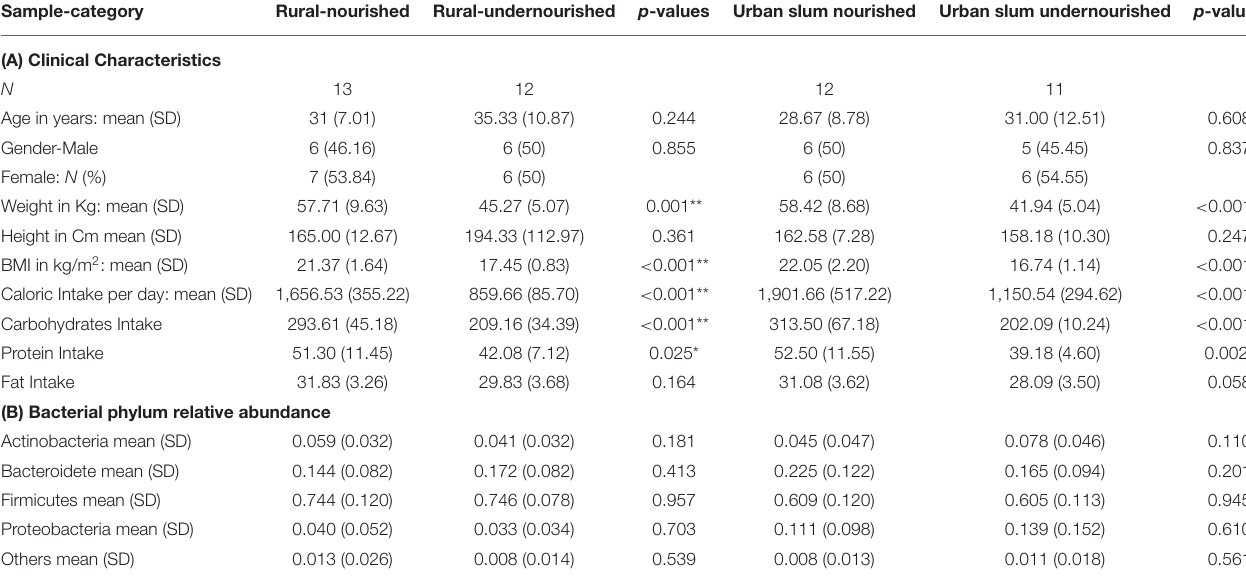
TABLE 1 | Characteristics of the study participants based on nutritional status (normal vs. undernourished) or location (rural vs. urban slum).